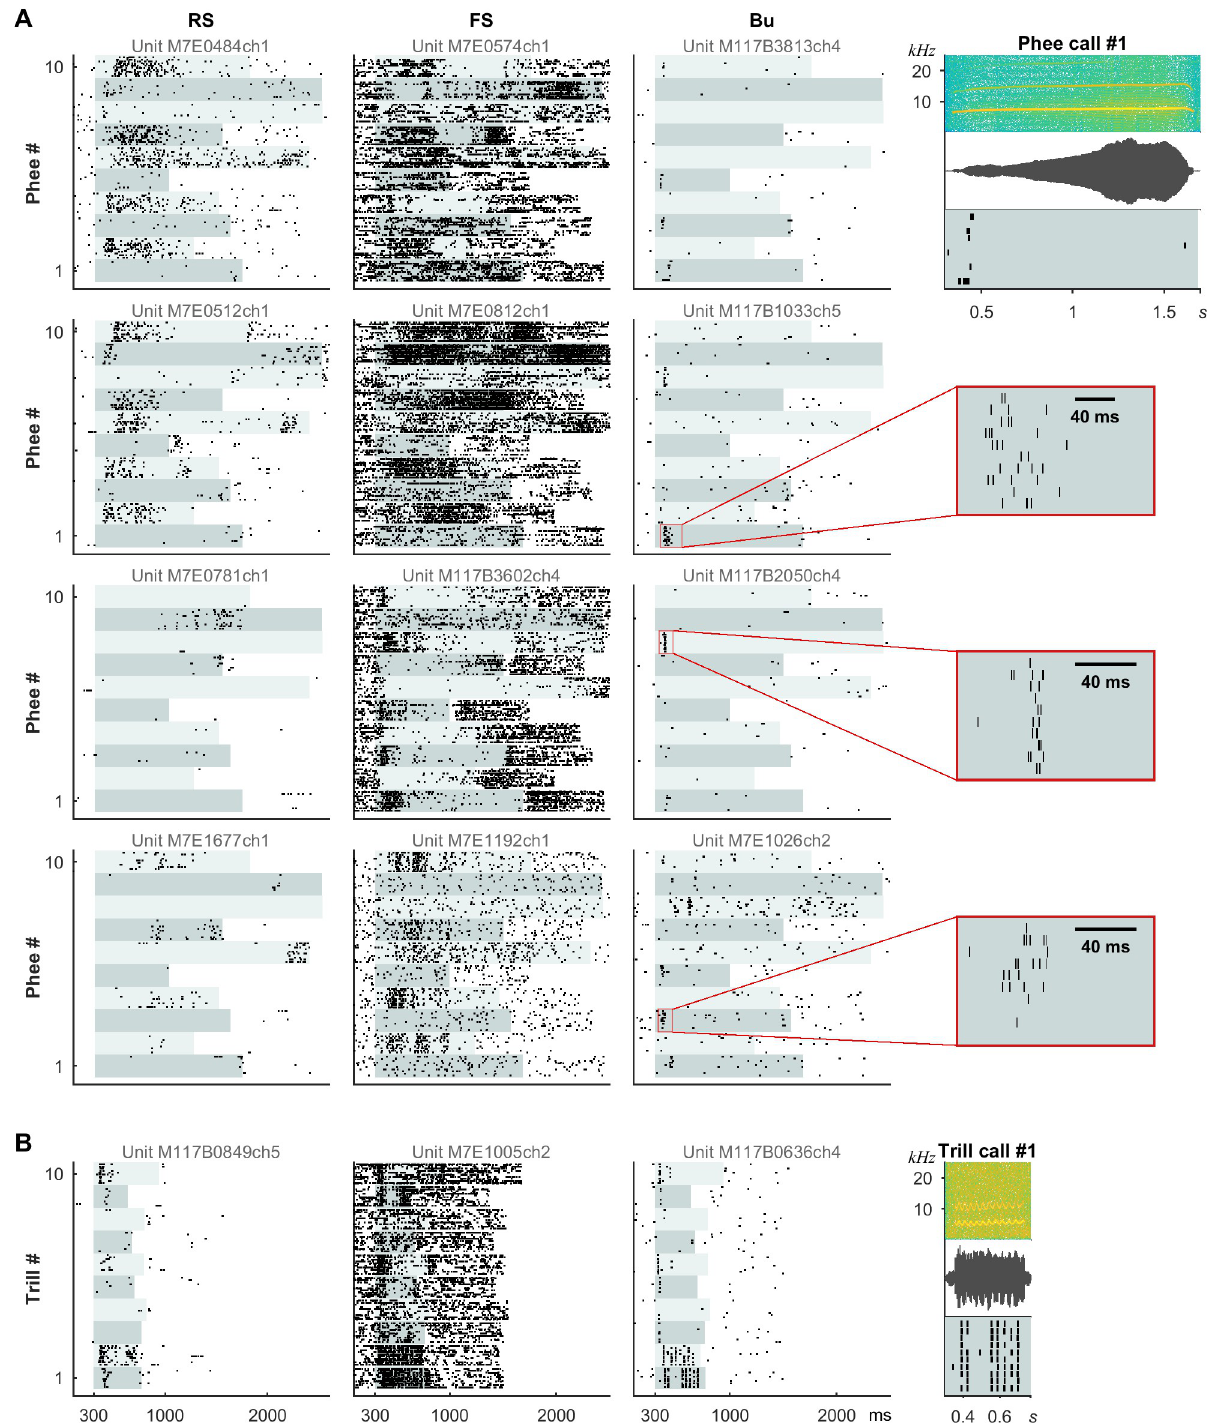
Fig 6. RS, FS, and Bu units had distinct types of responses to vocalizations analogous to their responses to sustained and SAM stimuli. Responses are shown to “Call Type Lists” consisting of example tokens of the sustained phee call or the rapidly fluctuating trill call . Example spectrograms, waveforms, and corresponding response raster plots for bursting units are shown on the right, while complete stimulus spectrograms can be seen in S6B and S6C Fig. (A) Columns show responses of 4 example units of each type to 10 prerecorded phees . Bu units responded at particular moments, often at the onset, while RS and FS units were excited or inhibited throughout the call. (B) A Bu unit phase-locked to the rapid modulation (approximately 30 Hz) in some examples of trill calls. An FS unit was also capable of representing the modulation, but with many more spikes per